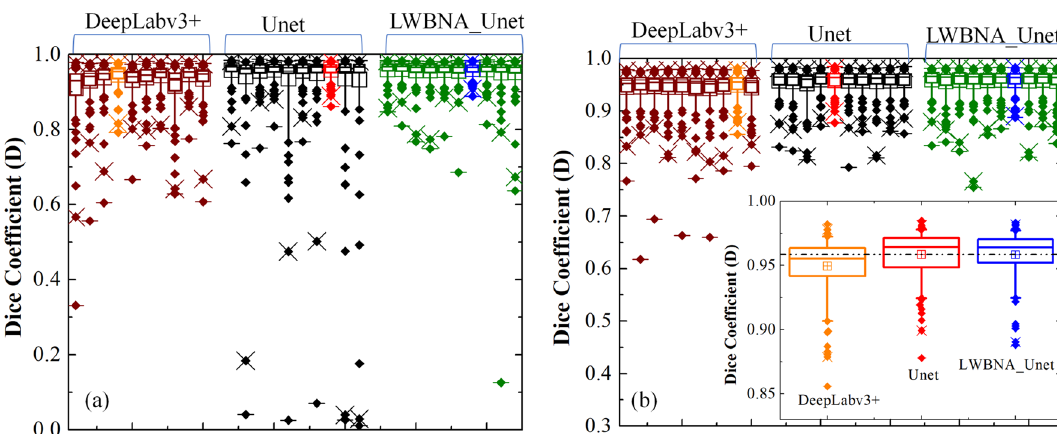
Figure 7. Boxplot showing spread in D for the testing dataset (segmentation of FAZ area) obtained from DeepLabV3 + , Unet, and LWBNA_Unet models trained for 10 times using ( a ) ‘callbacks’ function of tensorflow, and ( b ) training of models for fixed epochs of 500. The best trained model in each case is shown with orange, red, and blue curves. In both the cases, the lightweight model developed in present study surpasses the DeepLabv3 + , and Unet in terms of reproducibility, and generality of FAZ segmentation.